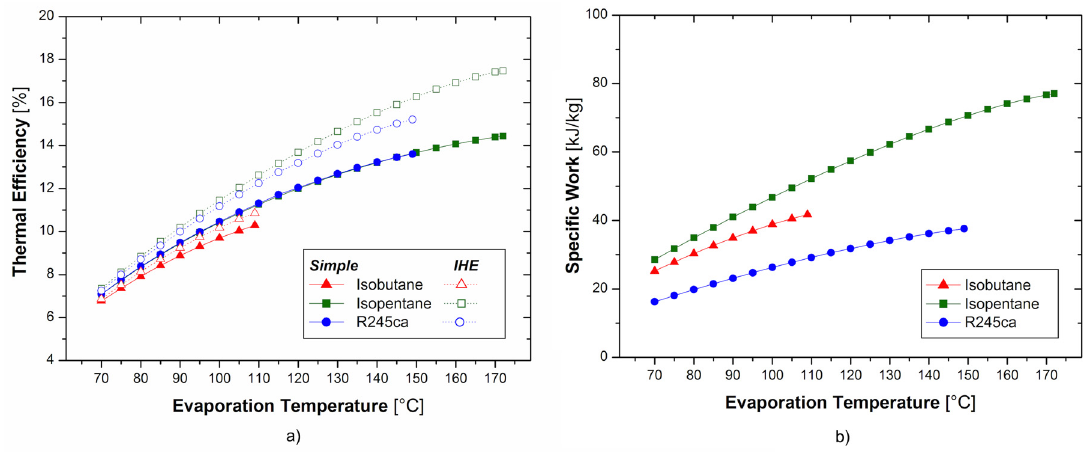
Figure 4. Influence of evaporation temperature on ORC efficiency ( a ) and specific work ( b ) (subcritical cycle).